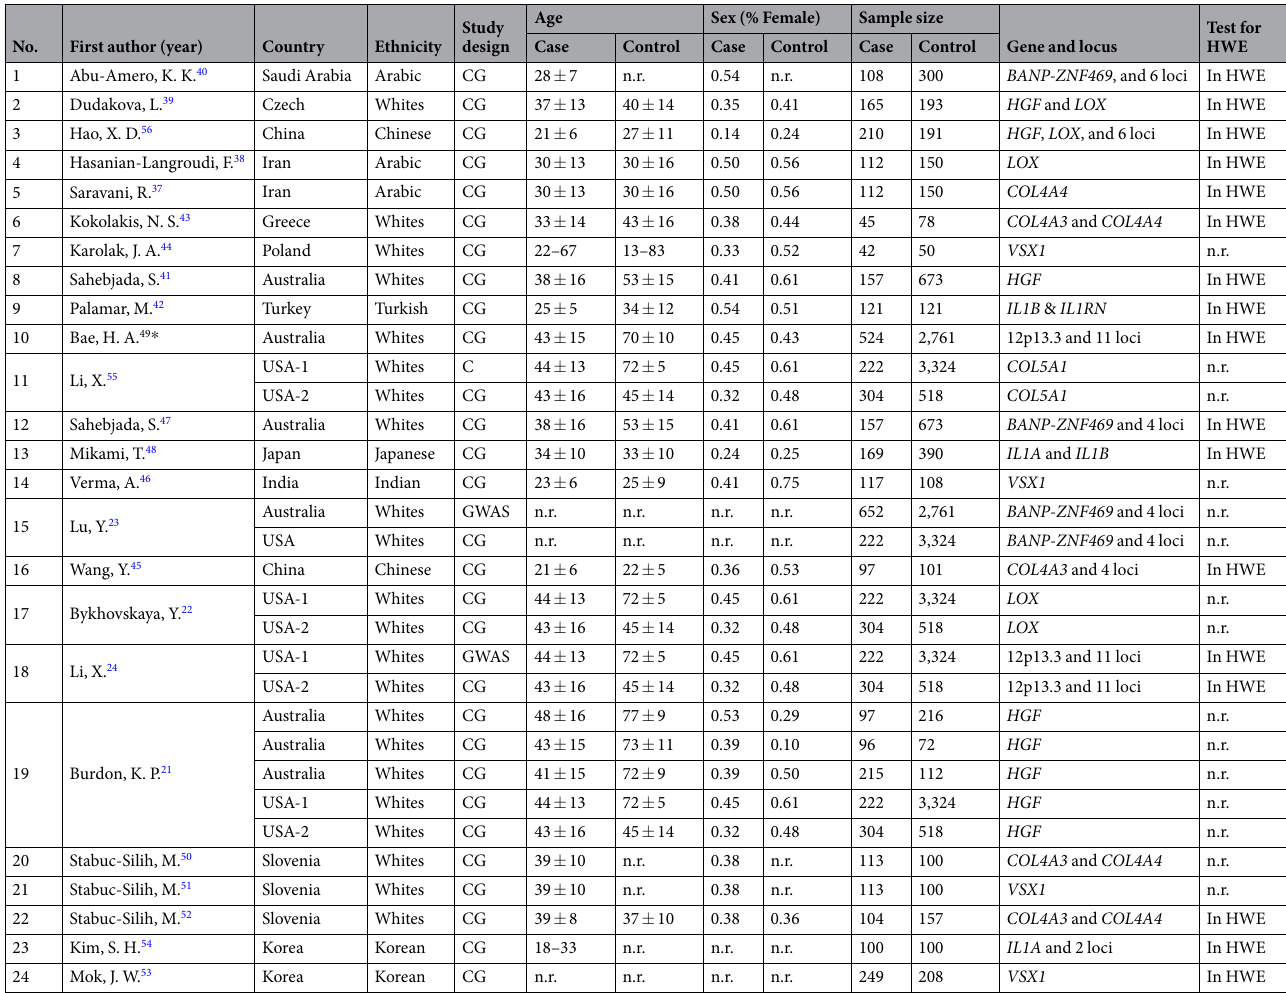
Table 1. Characteristics of eligible studies for the meta-analysis. * A small number of forme fruste Keratoconus was not excluded. BANP-ZNF469 = BTG3 associated nuclear protein-zinc finger protein 469; COL4A3 = collagen, type IV, alpha 3; COL4A4 = collagen, type IV, alpha 4; COL5A1 = collagen, type V, alpha 1; HGF = hepatocyte growth factor; IL1A = interleukin 1, alpha; IL1B = interleukin 1, beta; IL1RN = interleukin 1 receptor antagonist; LOX = lysyl oxidase; VSX1 = visual system homeobox 1. CG = candidate gene association study; GWAS = genome-wide association study; KCN = keratoconus; HWE = Hardy Weinberg equilibrium; PCs = principle components; n.r. = not